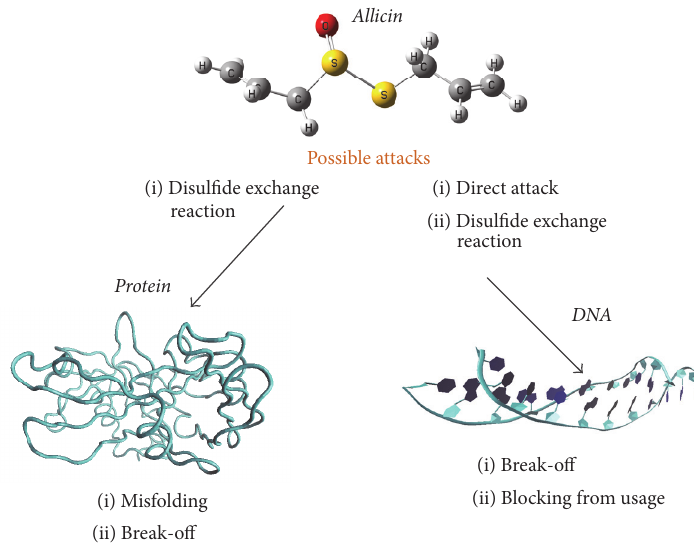
Figure 1: There are two possible allicin or its derivatives interactions: interacting with proteins or with DNA.